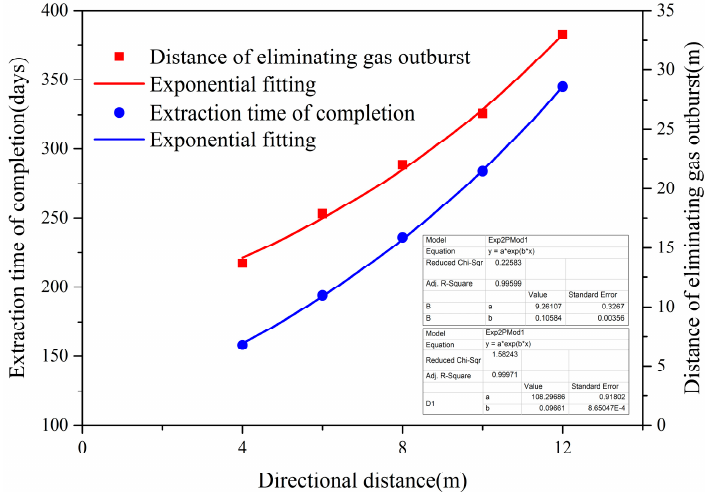
Figure 11. Effect of